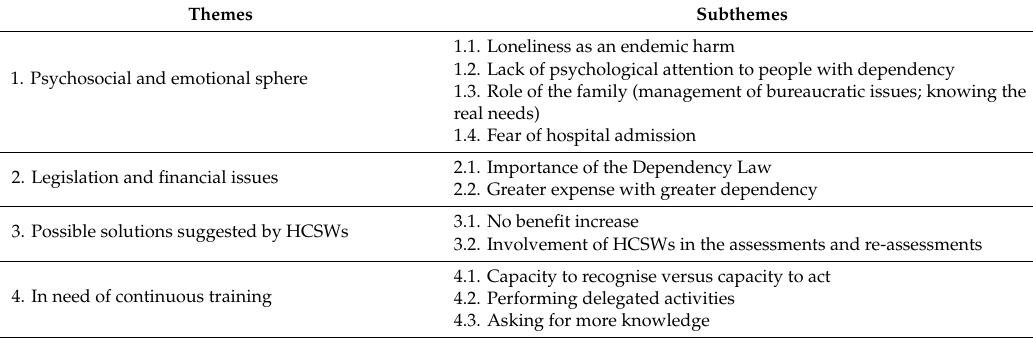
Table 4. List of themes and